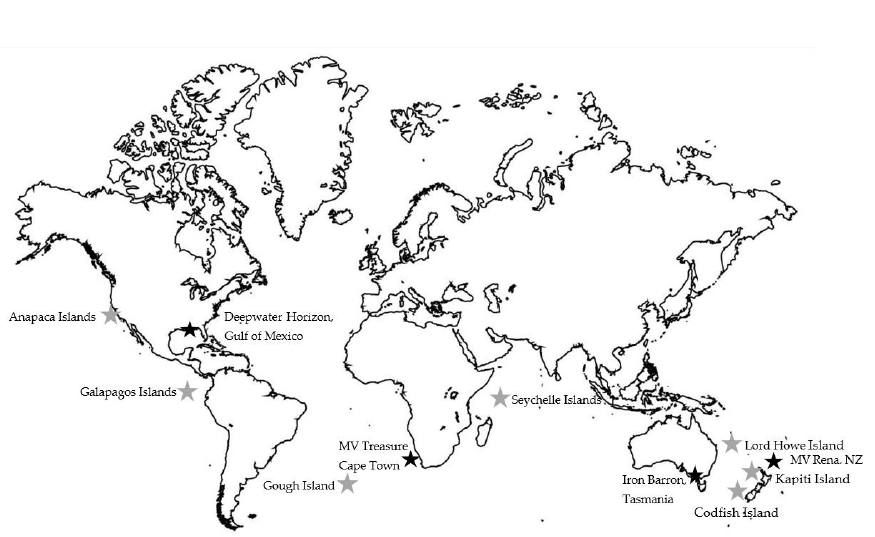
Figure 1. Locations of case studies. Oiled wildlife responses are shown as a black star. Eradication operations are shown as a grey star.